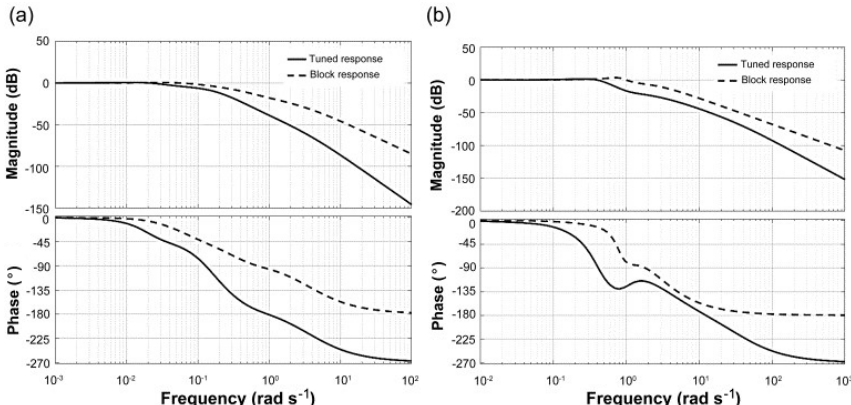
Figure 22. (a) Stability Analysis using Bode Plot with Respect to Reference Tracking for 2% Changes in H in and (b) Stability Analysis using Bode Plot with Respect to Reference Tracking for 15% Changes in H in .